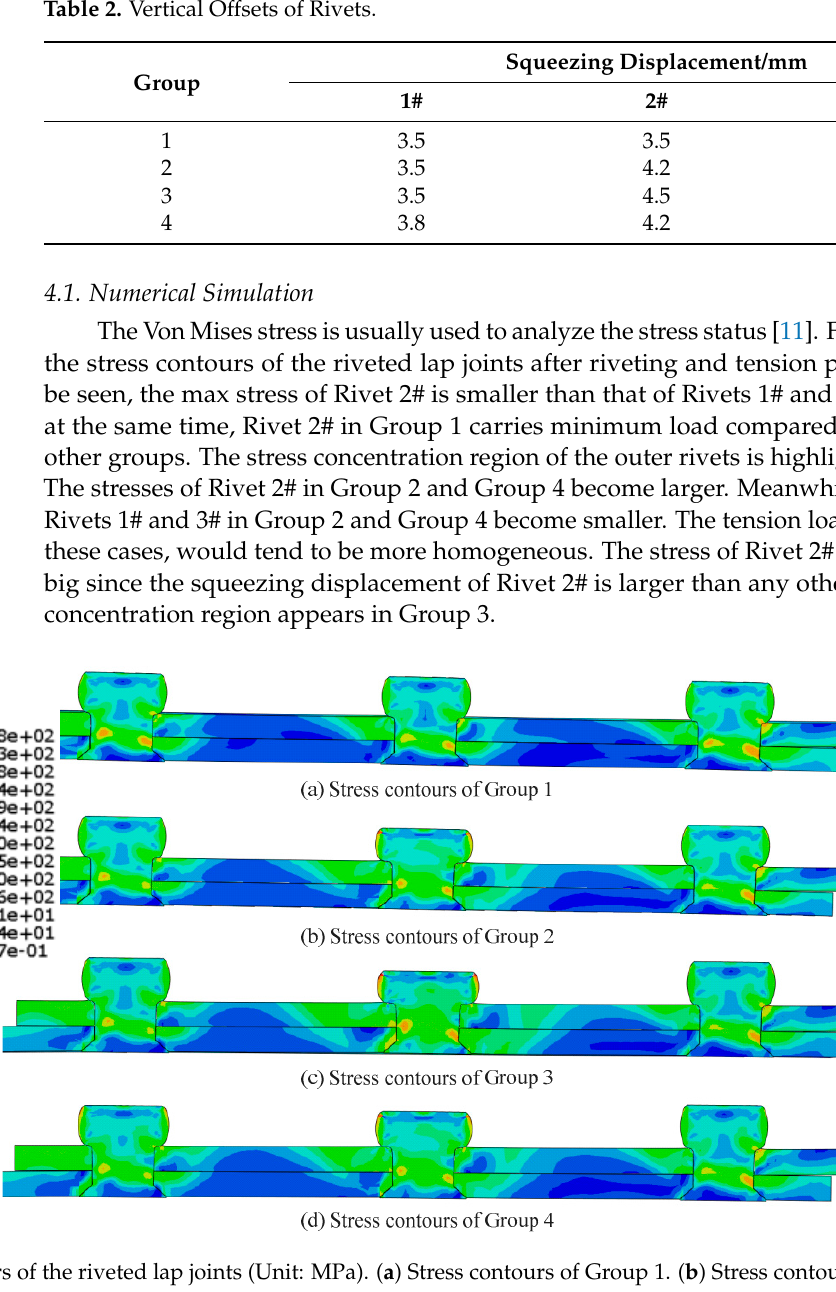
Figure 9. Tensile load transmission of a three-row riveted lap joint. The situation of tensile load transmission varies with different squeezing displace- ment combinations. When the squeezing displacement of these three rivets is kept the same and remains smaller (Group 1), the tensile load distribution is quite inhomogeneous. The outer sides take a larger part of tensile load than the middle. When the squeezing displacement of Rivet 2# become larger, Rivet 2# will gradually transfer a larger part of tensile load. The results of Group 2 and Group 4 achieve a relatively more homogeneous tensile load distribution. In Group 4 especially, each rivet takes approximately one-third of the tensile load. However, Rivet 2# in Group 3 takes a great part of tensile load, since the squeezing displacement exceeds the normal value. As analyzed before, for the inner sheet, the region most sensitive to tensile load is the interface of Part II and Part III around Rivet 3#. Since the interface has the minimum cross- sectional area with the largest tensile load, the interface becomes the most critical part of a riveted lap joint during the tensile stage. The deformation condition may be the worst. Figure 10 illustrates the structural deformation magnitude of the interface of Part II and